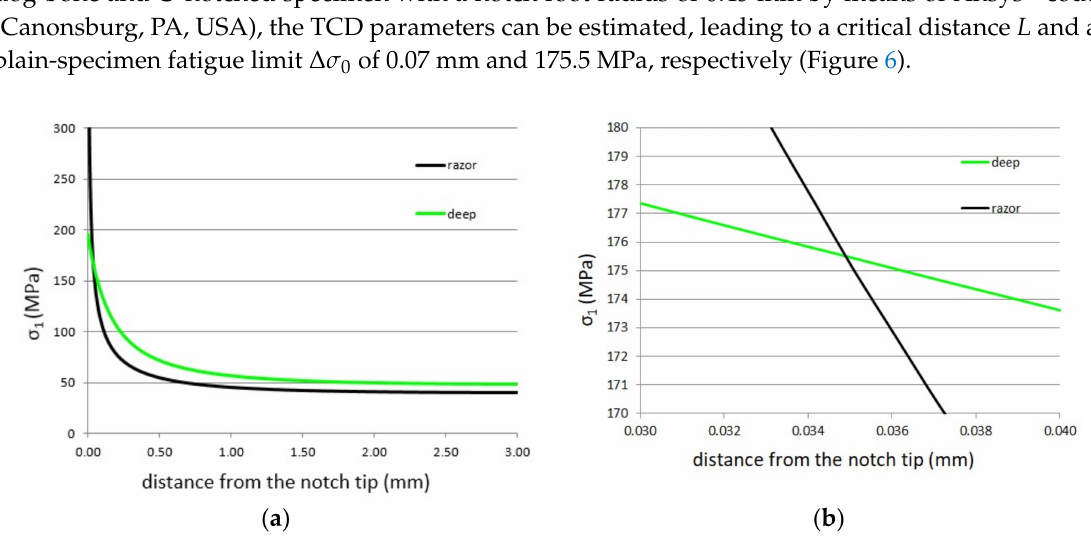
Figure 6. First principal stress distribution ahead of the notch tip for of “razor” and “deep” specimen ( a ); detail of the first principal stress distribution to determine the critical TCD parameters according to the point method, where the intersection occurs at half the value of the critical distance L ( b ).